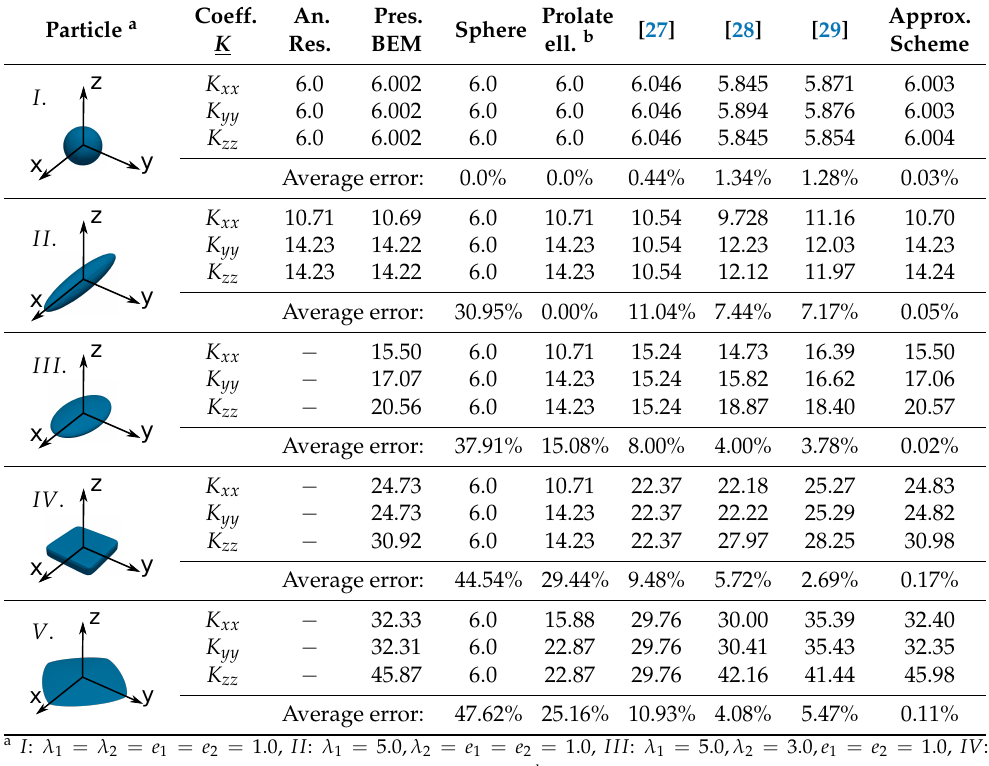
Table 2. K tensor coefficients are determined for particles I – V , using different methods. First, the analytical result is presented for the considered particle (applies only for particles I and II ). In the next column, a direct result from the present BEM code is presented. This is followed by the results obtained analytically with two simplified particle representations, namely the sphere and the prolate (considering λ 1 of the particle). After that, the empirical models from Haider and Levenspiel [27], Leith [28] and Holzer and Sommerfeld [29] follow. In the last column, the result of the derived approximation scheme is shown. Coeff. An. Particle a Res.